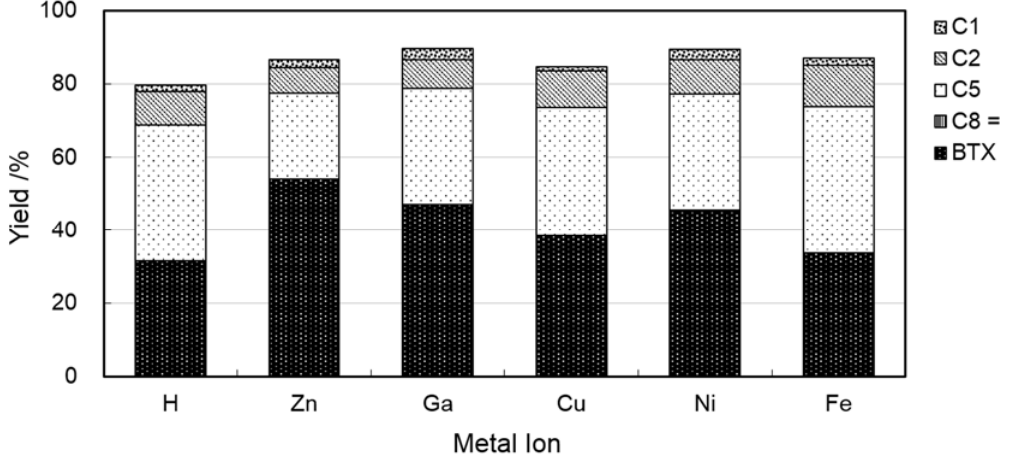
Figure 3. Catalytic activity of Zn(0.67 wt. %)-, Ga(0.25)-, Ni(0.24)-, Cu(0.71)-, Fe(0.25)-, and H-MFI zeolites for aromatization of 2-octanol at 773 K. Reaction conditions: